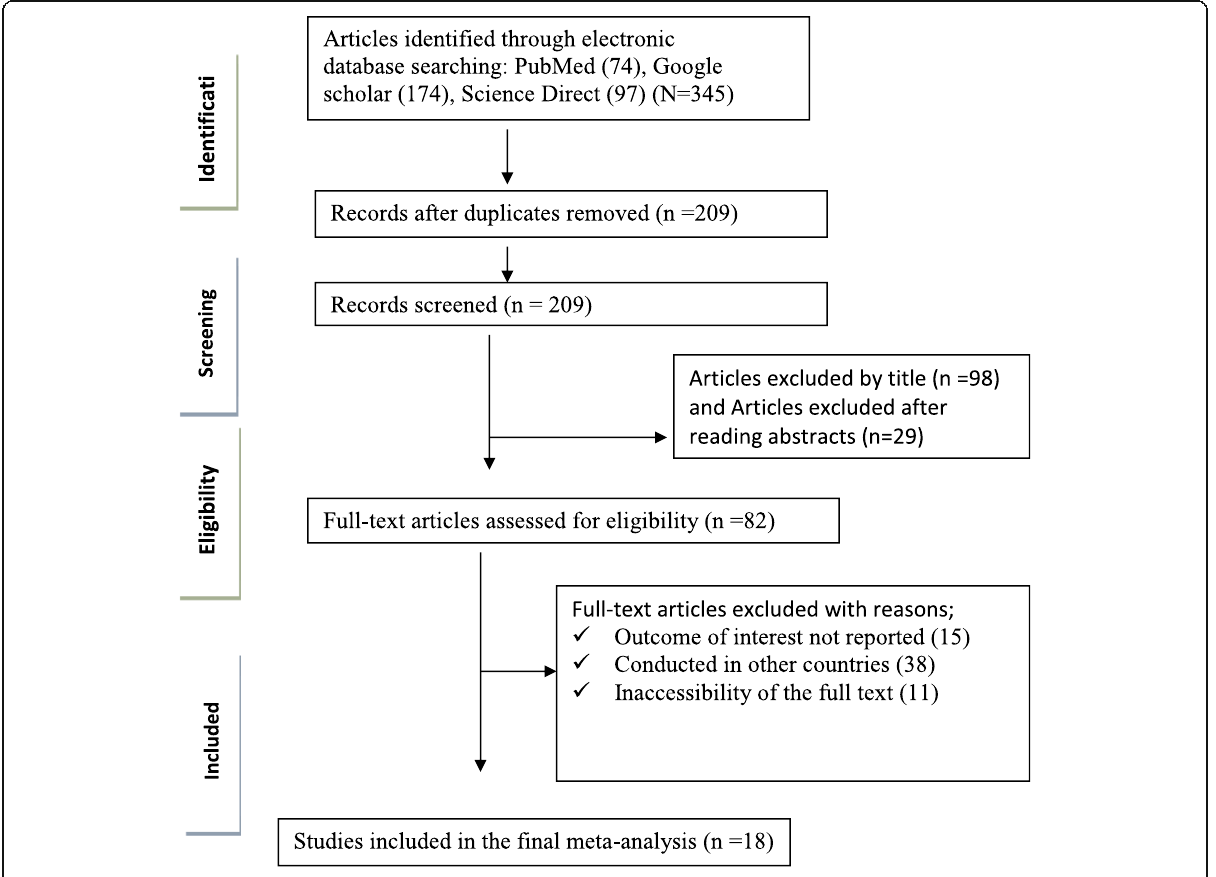
Fig. 1 PRISMA study selection flow diagram on first line treatment failure in